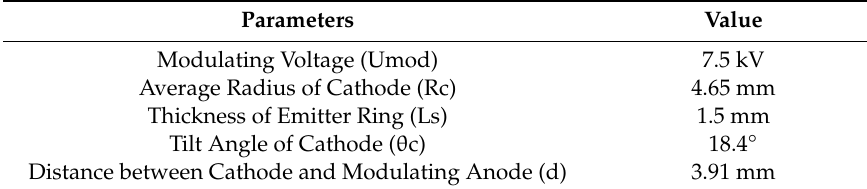
Figure 6. The value for ( a ) longitudinal momentum, ( b ) perpendicular momentum, and ( c ) transverse- Figure 6. Thevaluefor( a )longitudinalmomentum,( b )perpendicularmomentum,and( c )transverse-to-axial to-axial velocity ratio as a function of axial distance. velocity ratio as a function of axial distance. Table 5. Optimal geometric factors of MIG.